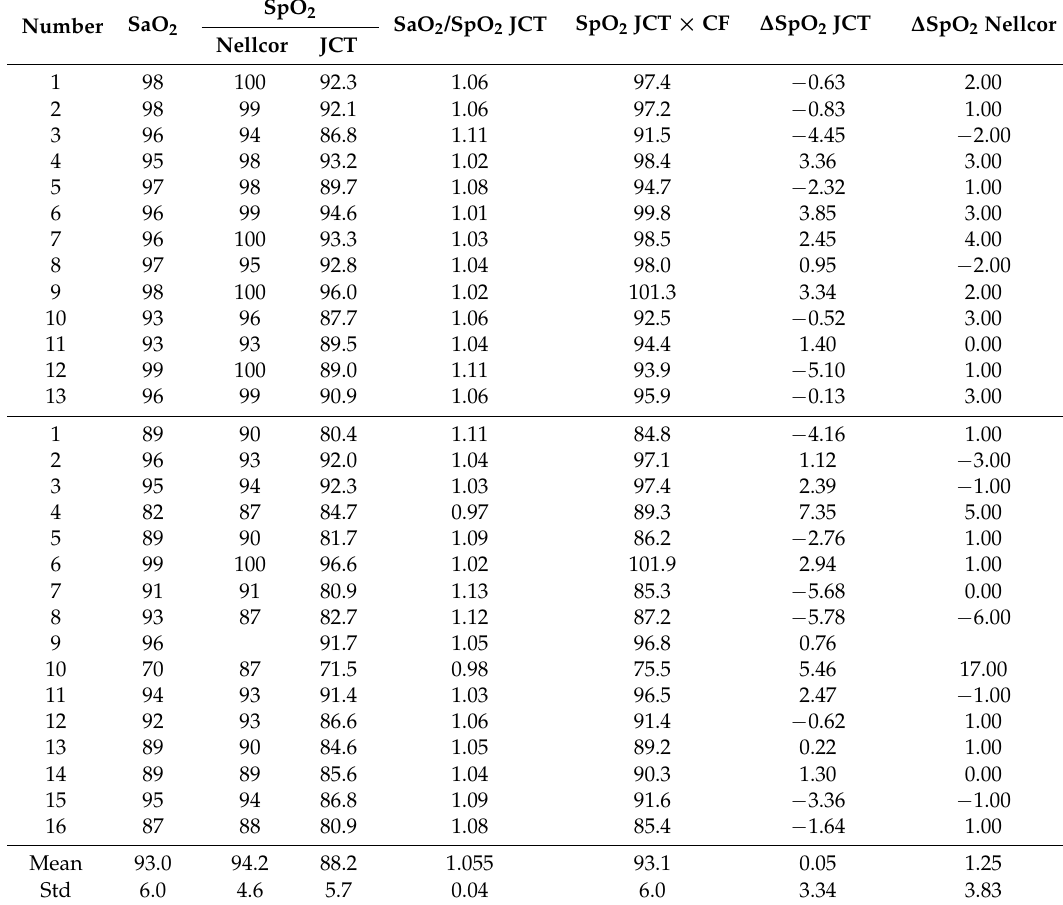
Table 1. SpO 2 values as obtained by the Nellcor pulse oximeter and the JCT pulse oximeter and SaO 2 measured by an invasive technique in the pediatric intensive care unit (PICU) (first 13 examinations) and the neonatal intensive care unit (NICU) (last 16 examinations). Also shown are SaO 2 /JCT–SpO 2 and the difference (marked by ∆ ) between SaO 2 and SpO 2 , as obtained by each pulse oximeter (with the correction, in the case of the JCT pulse oximeter). CF—correction